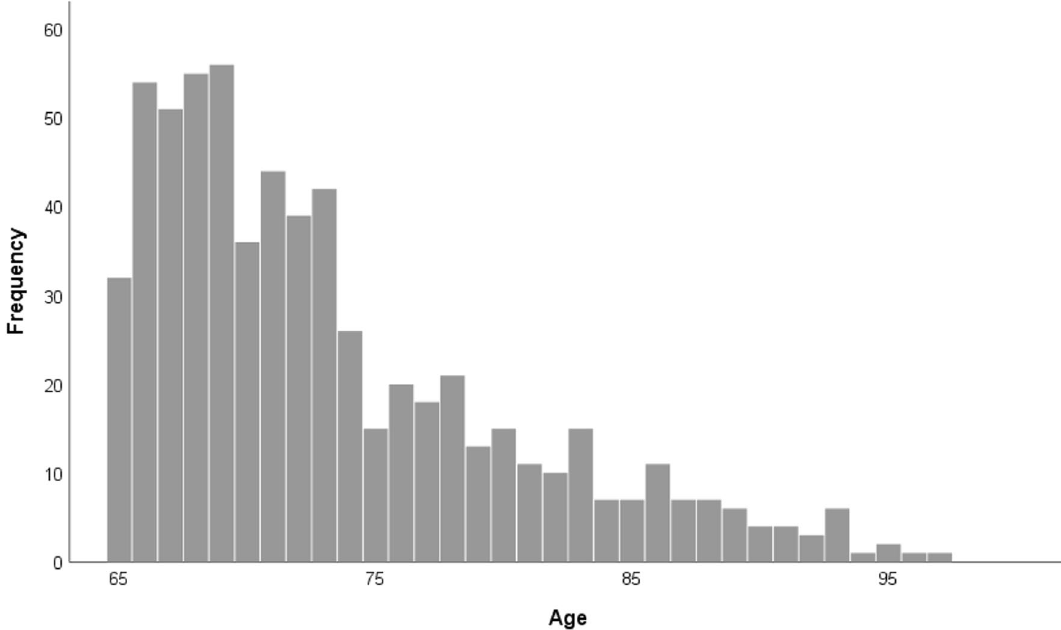
Figure 1. Frequency distribution of